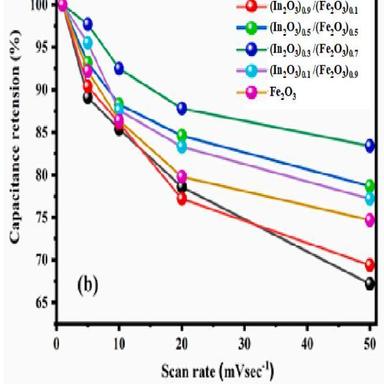
(a) Specific capacitance (Fg− 1 ) (b) Retention (%) in specific capacitance of all samples concerning capacitance of that sample at 1 mV s -1 vs applied scan rates (mVsec− 1 ).